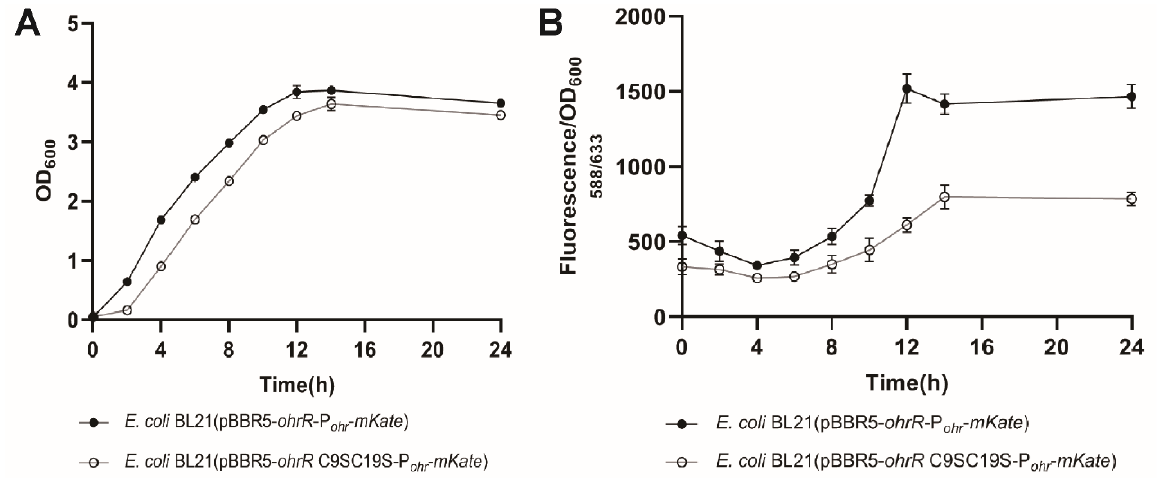
Figure 4. PaOhrR senses endogenous sulfane sulfur. ( A , B ) Representative optical density (OD 600nm ) growth curve and mKate fluorescence of E. coli BL21 (pBBR5-OhrR-P ohr -mKate) and E. coli BL21 (pBBR5-OhrR(C9SC19S)-P ohr -mKate suspensions. Cells were grown in LB medium at 37 °C and were analyzed at different growth stages. Data are averages of three experiments with standard deviations.